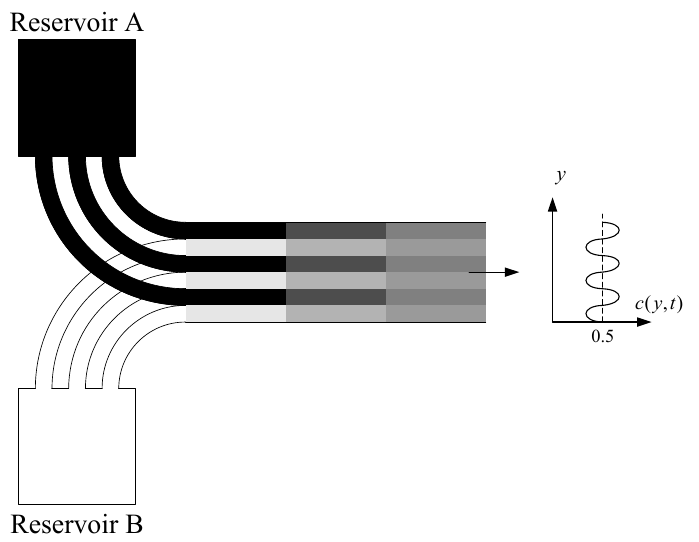
Figure 3. Sketch illustrating the principle of hydrodynamic focusing. The graph shows a typical concentration distribution as a function of y .